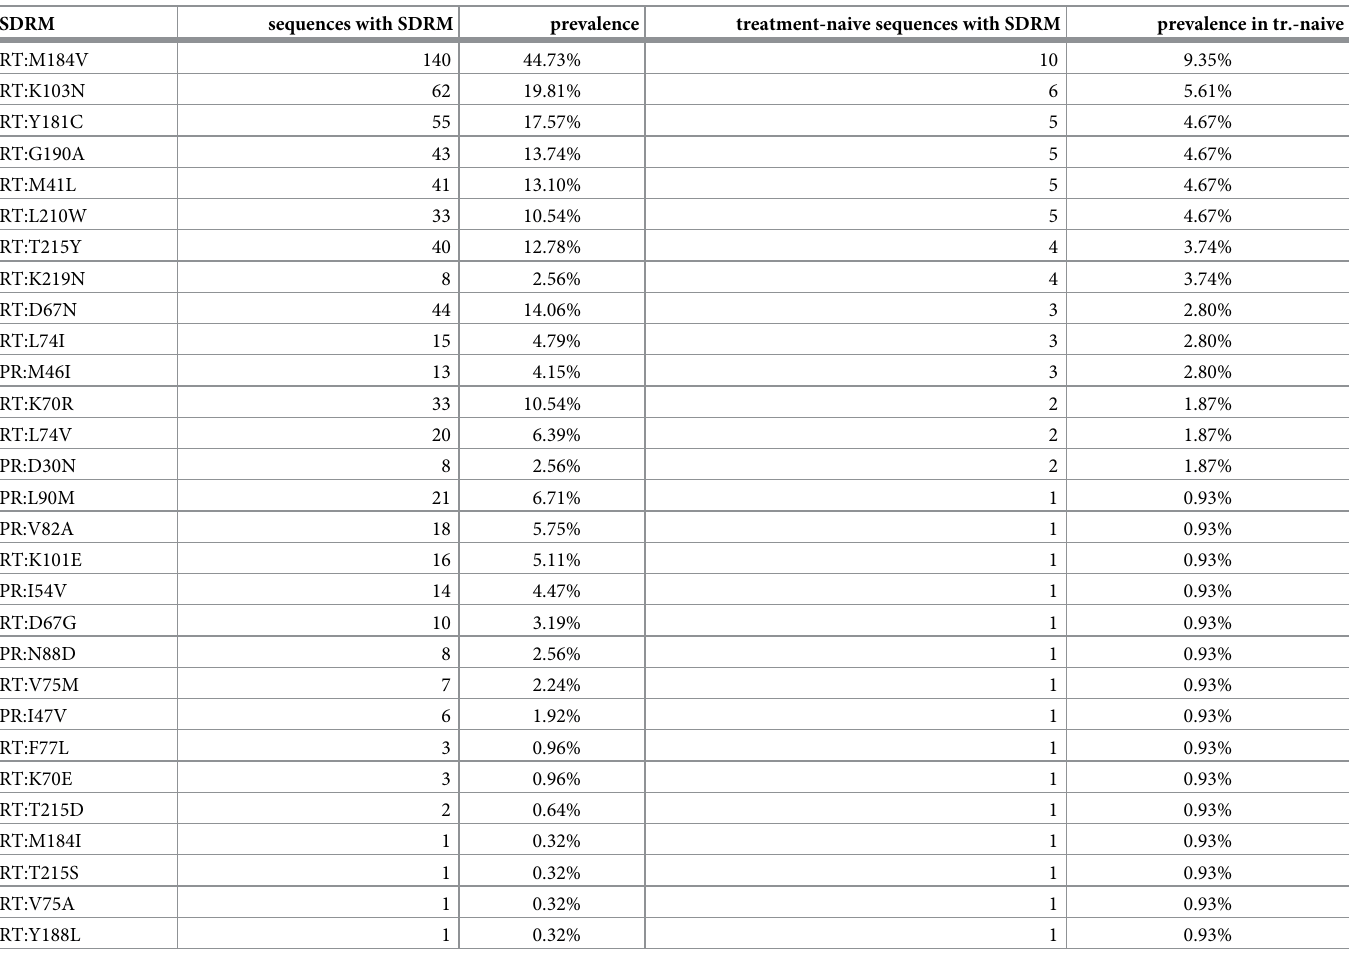
Table 4. Statistics on SDRMs present in at least one treatment-naive CRF19